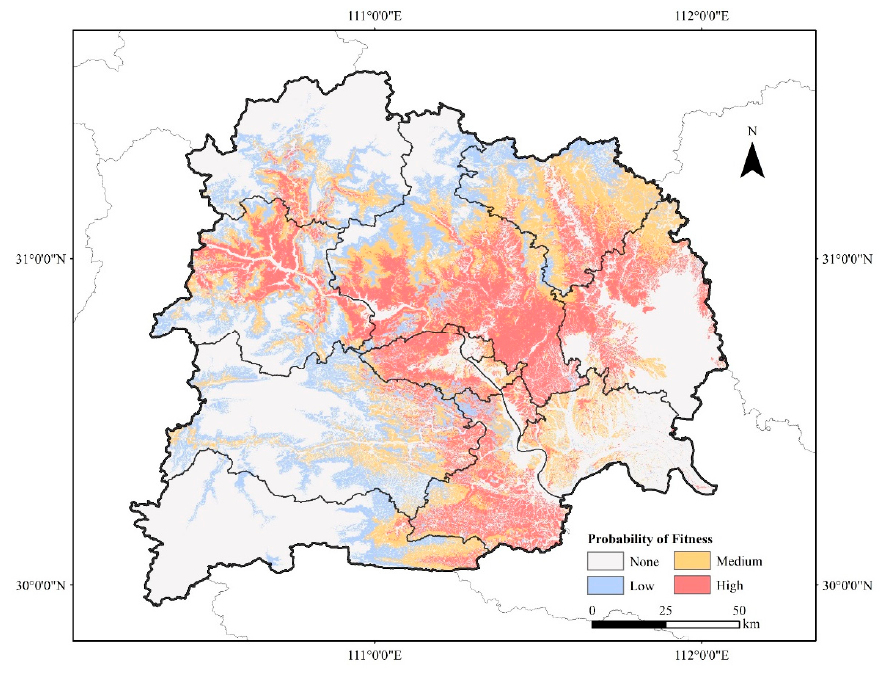
Figure 3. Prediction of potential suitable area for PWD in Yichang City.